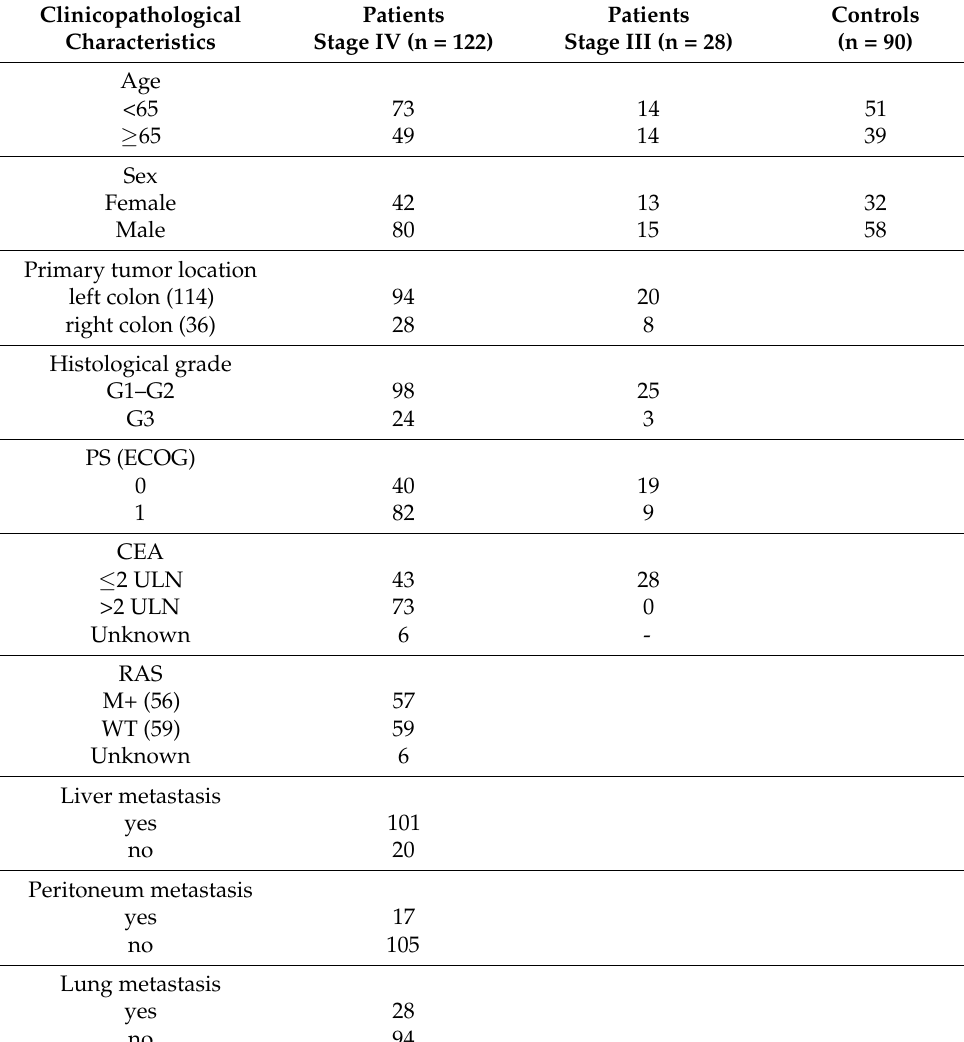
Table A1. The Characteristics of